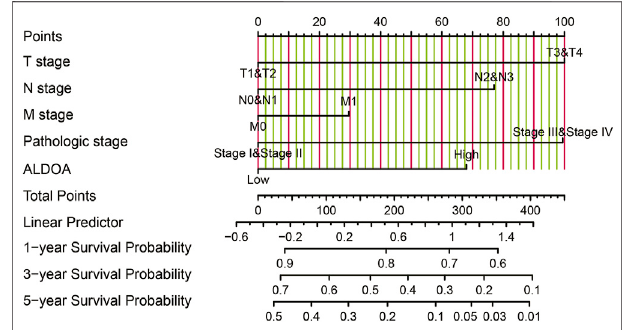
FIGURE 6 | The nomogram to predict 1-, 3- and 5-years overall survival